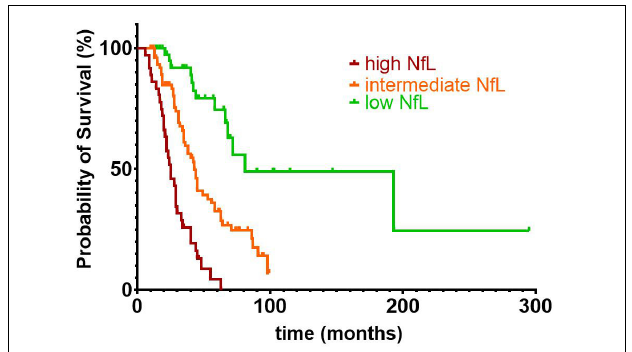
FIGURE 5 | Kaplan–Meier survival curves and log-rank test showed significant differences in survival [ χ 2 (2) = 56.505, p < 0.001], when trichotomizing the ALS patients into groups with high ( n = 36), intermediate ( n = 77), and low ( n = 43) CSF NfL concentrations. Estimated marginal means of the previously described analysis of covariance were used for the subdivision of ALS patients into groups with high (Log[NfL] > 4.149), intermediate (3.651 < Log[NfL] < 4.149), and low (Log[NfL] < 3.651) CSF NfL concentrations. Of the 156 ALS patients included in the survival analysis, 97 patients (13 with low, 51 with intermediate, and 33 with high CSF NfL levels) reached the endpoint death or tracheostomy, whereas the remaining 59 patients were censored. ALS, amyotrophic lateral sclerosis; CSF, cerebrospinal fluid; NfL, neurofilament light chain.